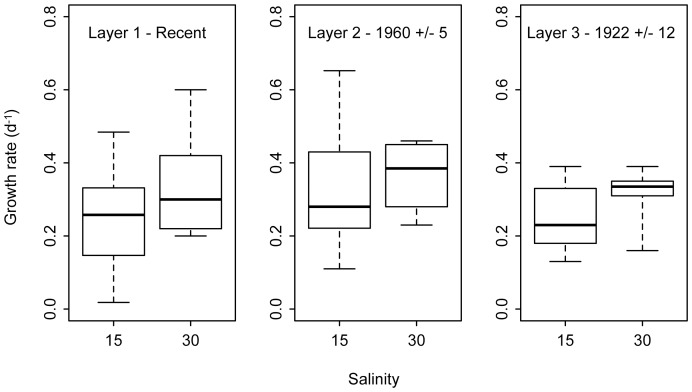
Growth performance of Pentapharsodinium dalei strains according to sediment core layer and salinity level.Boxplots show range (whiskers), median (bold line), and interquartile range (box height) for growth rates at salinity 15 and 30 for the three sediment core layers.